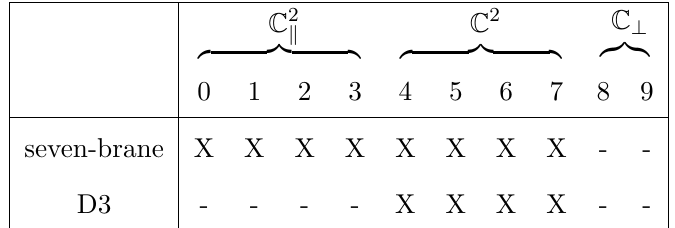
Figure 1 . IIB brane engineering of the e H ( k )